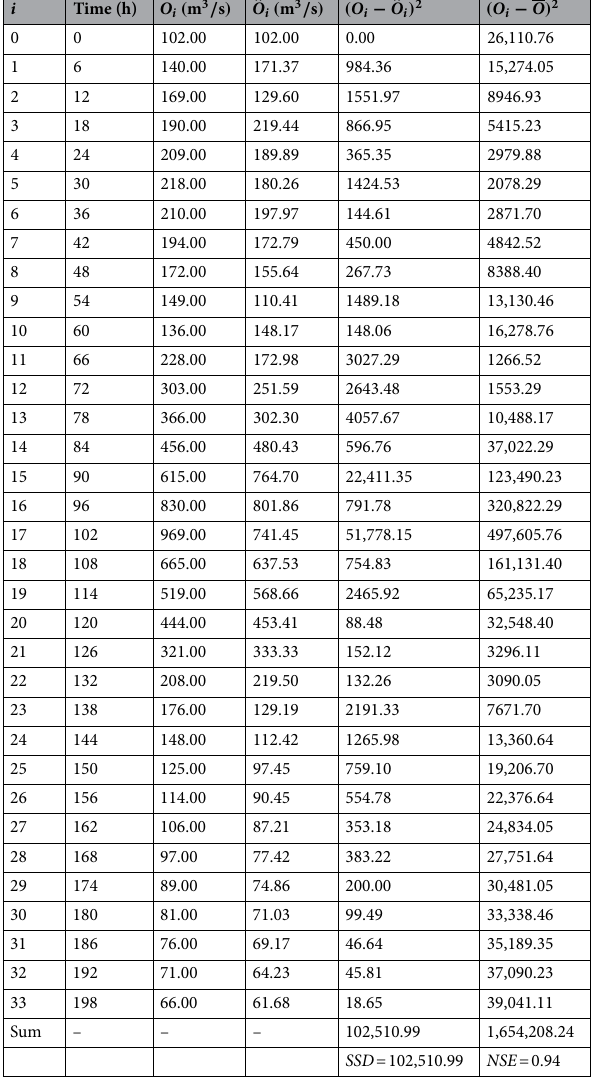
Table 4. Observed and simulated outflows for the Wye River Benchmark